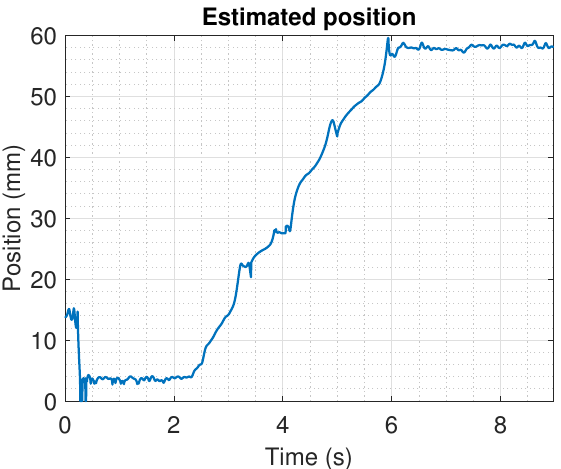
Figure 16. Estimated position using the data obtained from the sensor